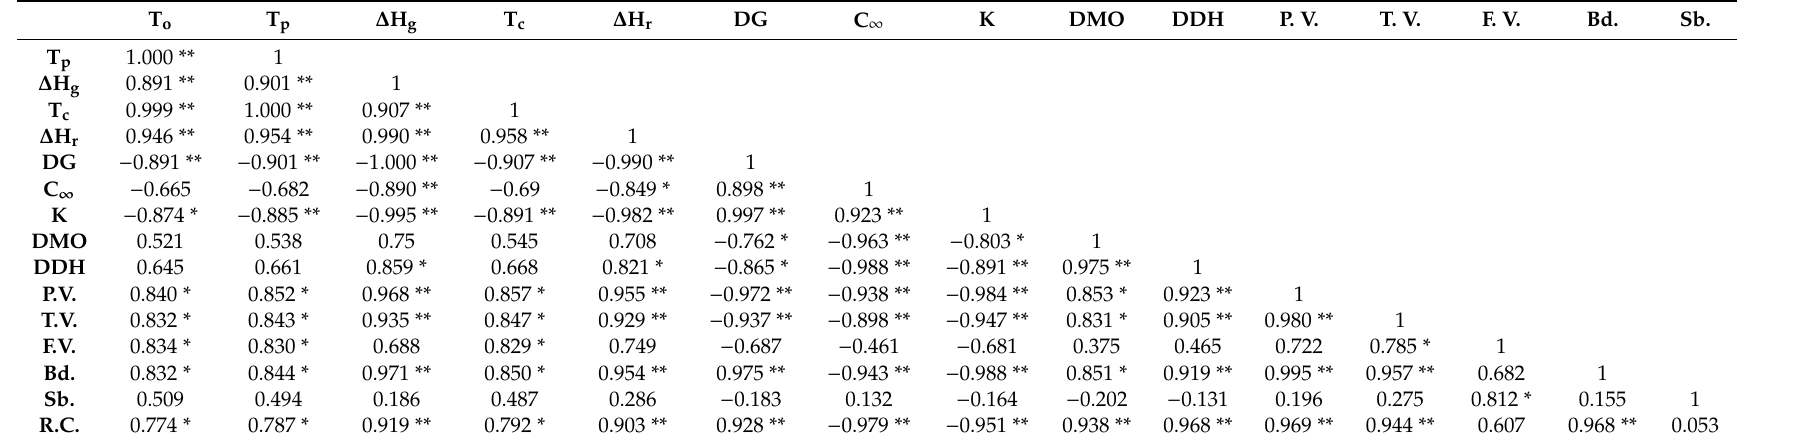
Table 4. Correlation analysis between structural changes and digestibility of